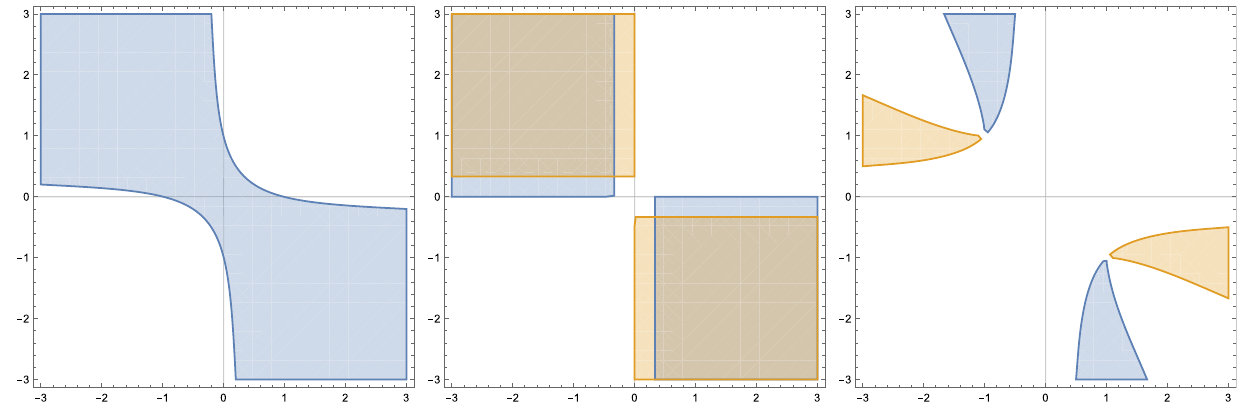
Fig. 13 Regions (blue) in the parameter space ( z 1 , z 2 ) where good AdS 3 vacua exist in SO ( 5 ) gauge group. From left to right, these figures correspond to the cases of ( k 1 = k 2 = − 1 ) , ( k 1 = − 1 , k 2 = 0 ) , ( k 1 = − k 2 = − 1 ) , respectively. The orange regions are obtained from interchanging k 1 and k 2